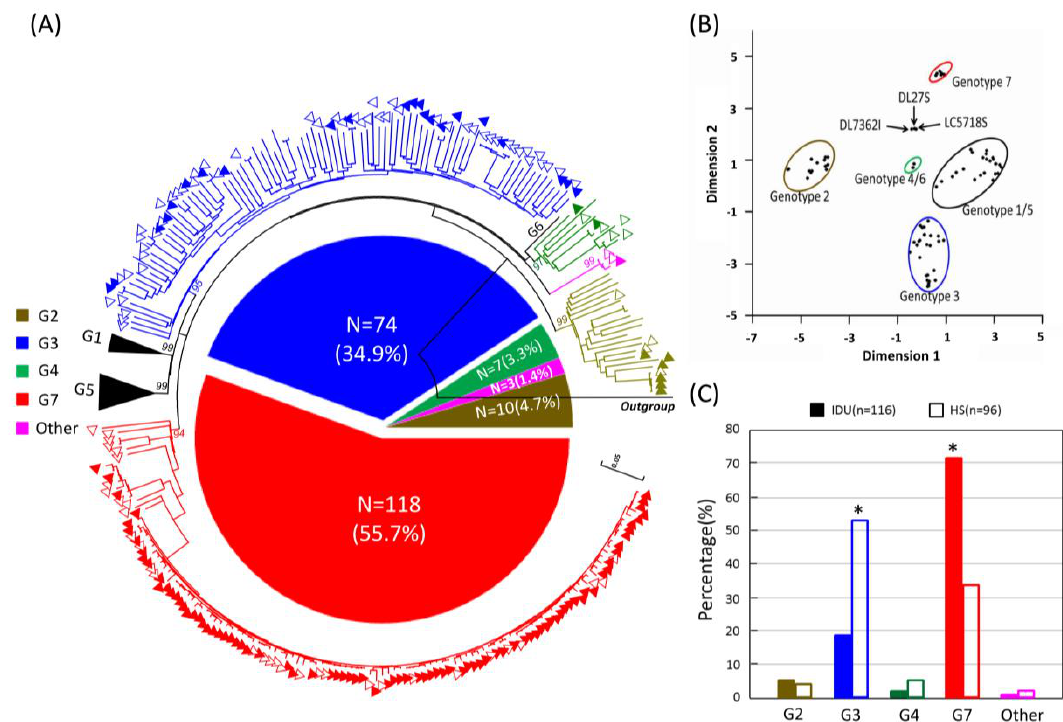
Figure 2. Genotypic analyses of human Pegivirus-1 (HPgV-1) and its distribution between injected drug users and heterosexual individuals in Yunnan, China. ( A ) A circular phylogenetic tree based on the partial E2 sequences amplified from the 212 human immunodeficiency virus-1 (HIV-1)-infected individuals. The different genotypes are shown in different colors, as indicated on the left of the tree (other means the unclassified group) and the open and closed triangles indicate injecting drug users (IDUs) and heterosexual contact (HS), respectively. The pie chart inside the tree shows the percentages of the various HPgV-1 genotypes; ( B ) Multivariate principal coordinate analysis (PCOORD) of partial E2 sequences of HPgV-1 (filled circles); ( C ) Comparison of HPgV-1 genotype distributions among IDUs and heterosexuals in Yunnan, China. The distribution significance of genotype 7 and 3 among the IDUs and heterosexuals were presented with asterisks ( p < 0.05).